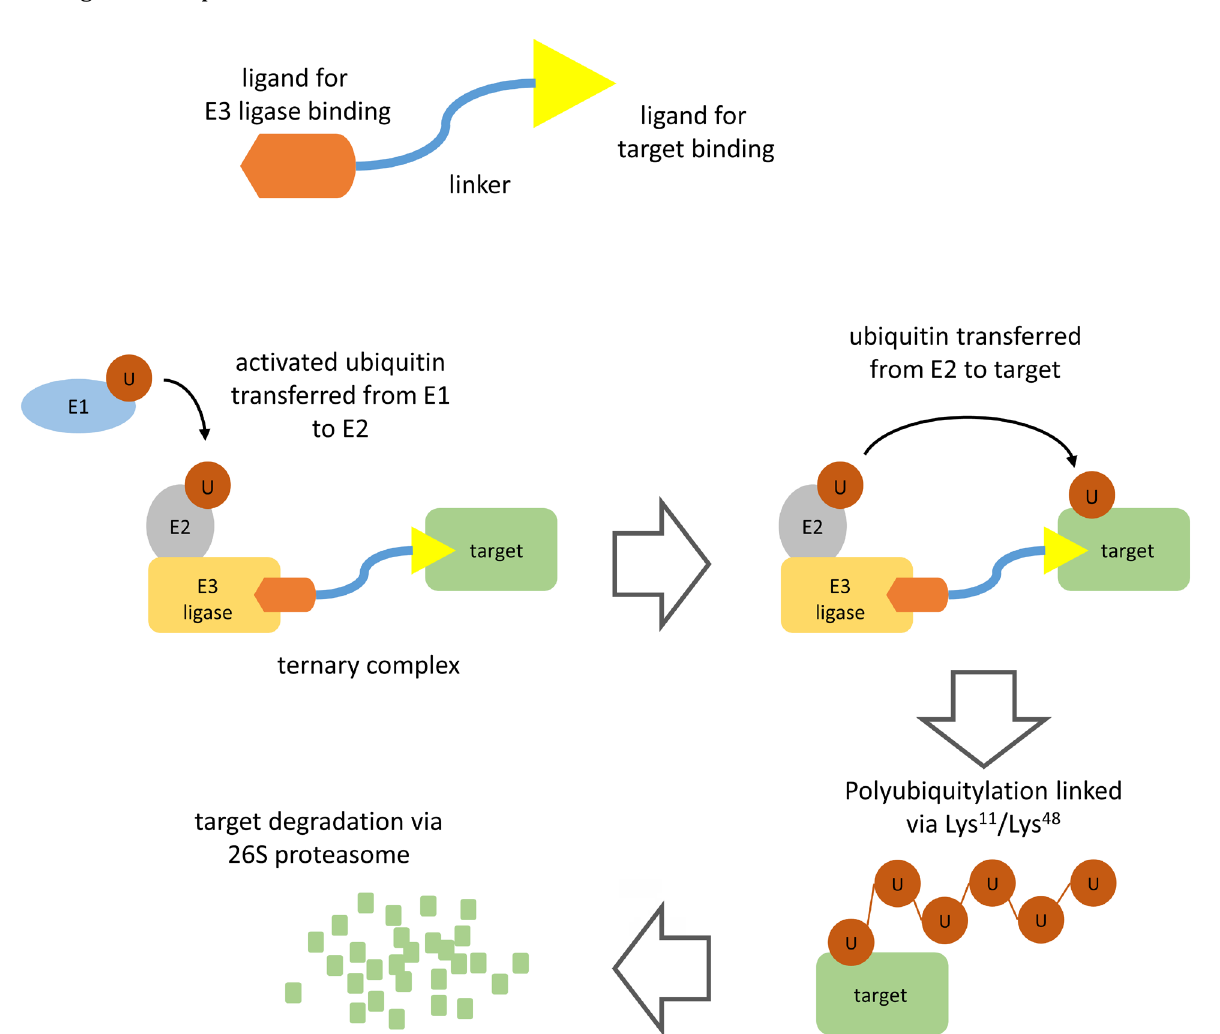
Figure 1. PROTAC-mediated target degradation. The figure illustrates the basic structure of a PROTAC (top) and the mechanism of PROTAC-mediated target degradation (bottom). Interaction of the PROTAC with its target and an E3 ligase (TC formation) facilitates multiple rounds of target ubiquitylation followed by target degradation via the 26S proteasome. The PROTAC and E3 ligase are released and are therefore available for further rounds of PROTAC-mediated